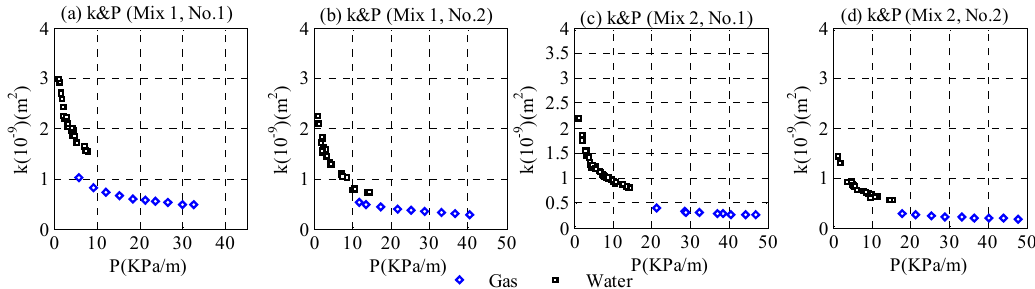
Figure 6. The permeability and pressure gradients of the pervious concrete samples.